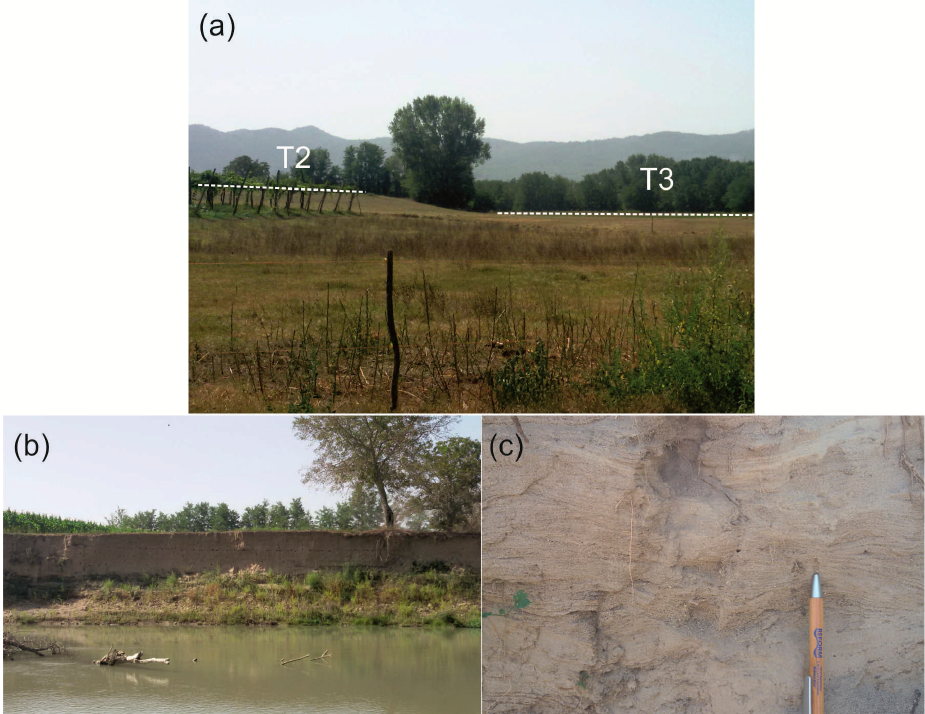
Figure 16. ( a ) View of T2 and T3 terraces in the Volturno River valley; ( b ) T3 deposits exposed along the Volturno fluvial scarp; ( c ) detail of thinly laminated sandy-silty T3